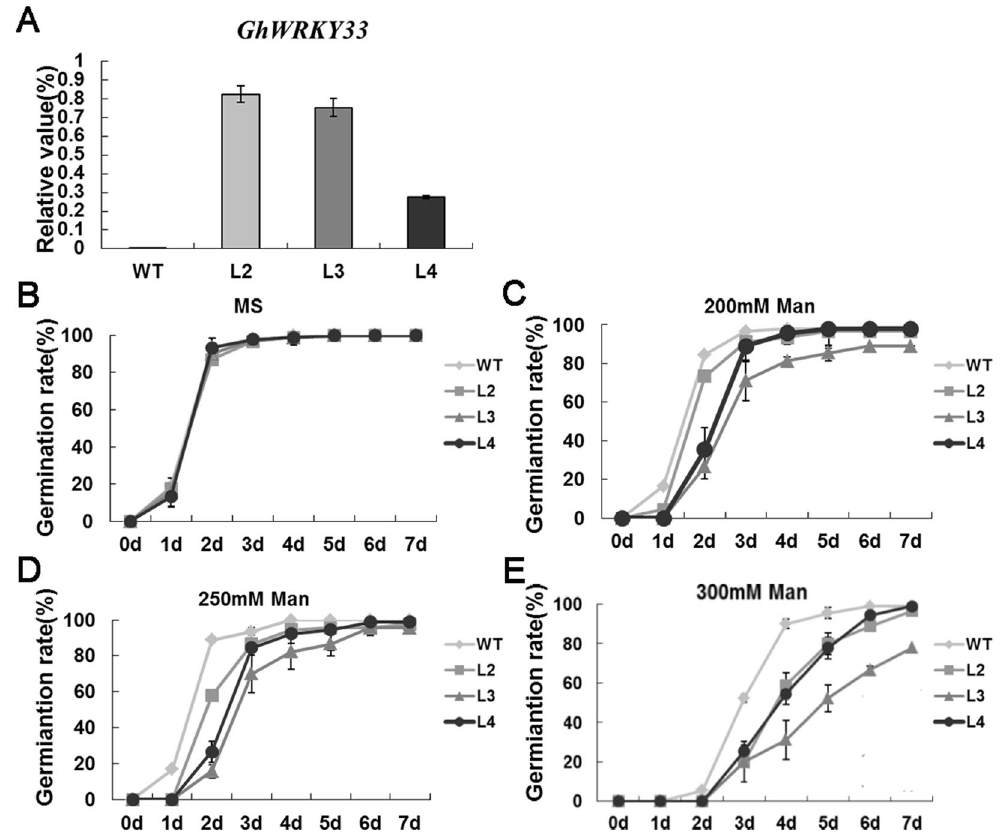
Figure 4. Assay of seed germination rate of GhWRKY33 overexpression transgenic Arabidopsis with mannitol treatment. ( A ) Quantitative RT-PCR analysis of GhWRKY33 expression in the transgenic lines and wild type. ( B–E) Statistical analysis of seed germination rate. Seeds of the transgenic lines and wild type were germinated on MS medium ( B ), MS medium with 200 mM mannitol ( C ), MS medium with 250 mM mannitol ( D ), and MS medium with 300 mM mannitol ( E ). Each curve represents an average of three replicates. WT, wild type; L2, L3 and L4, three GhWRKY33 overexpression transgenic